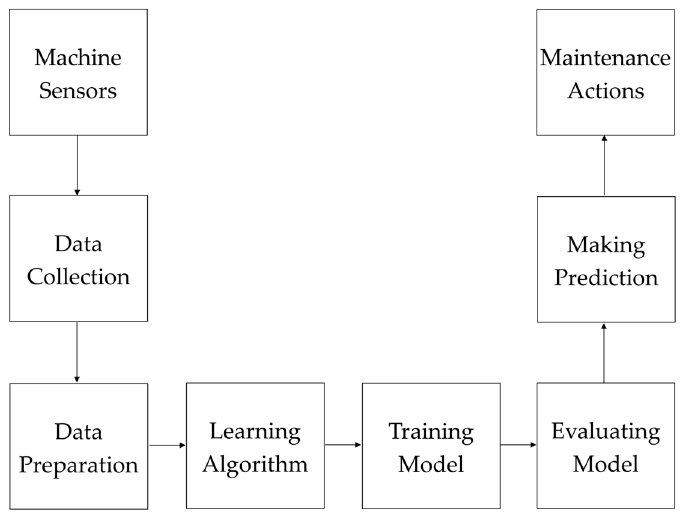
Figure 1. The general structure of the proposed predictive model.